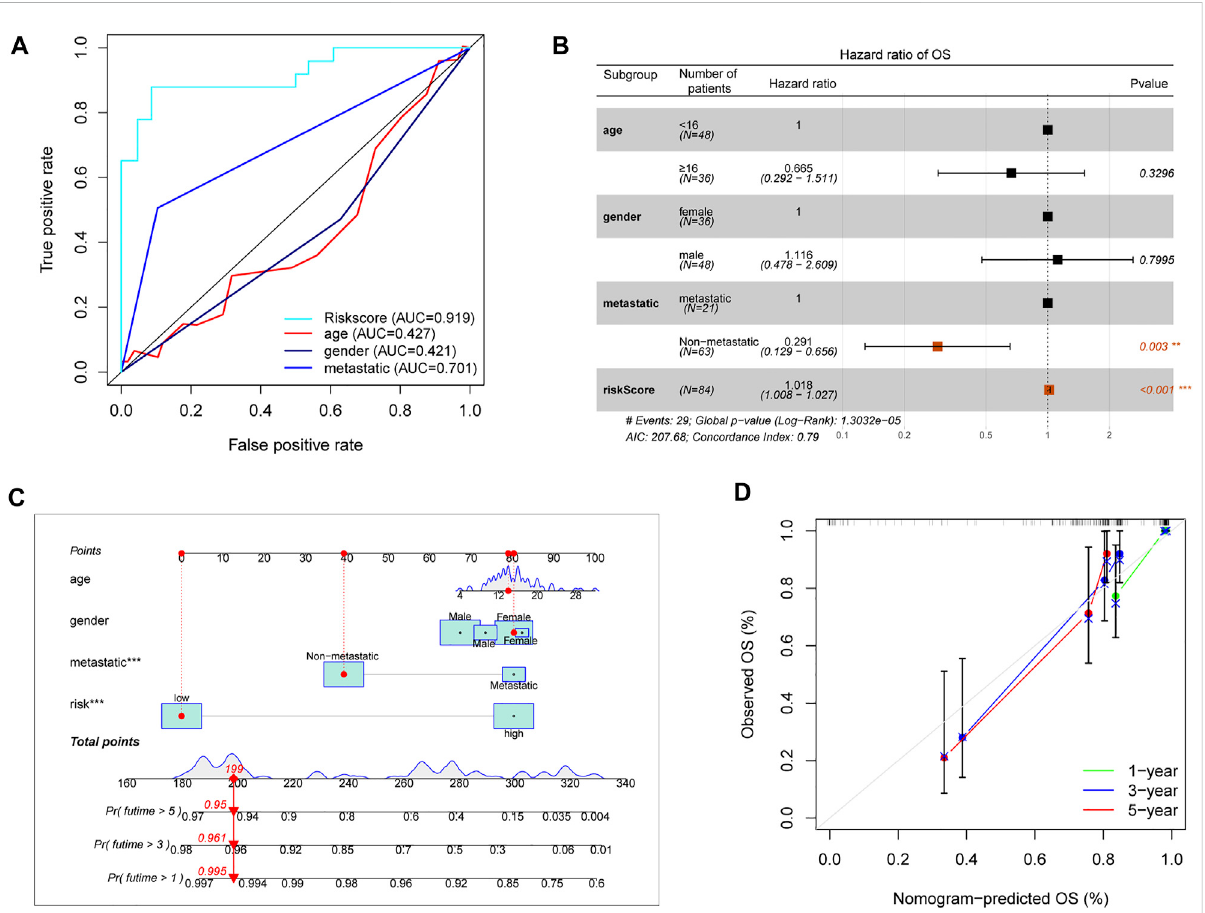
FIGURE 5 Assessment prognostic value of risk score model and the nomogram. (A) The prediction ability of the risk score model and other clinicopathological features. (B) Analyses of prognostic prediction factors through multivariate Cox analyses. (C) Nomogram for predicting 1/3/5- years survival rates of OS patients. (D) 1/3/5-year calibration curve of the